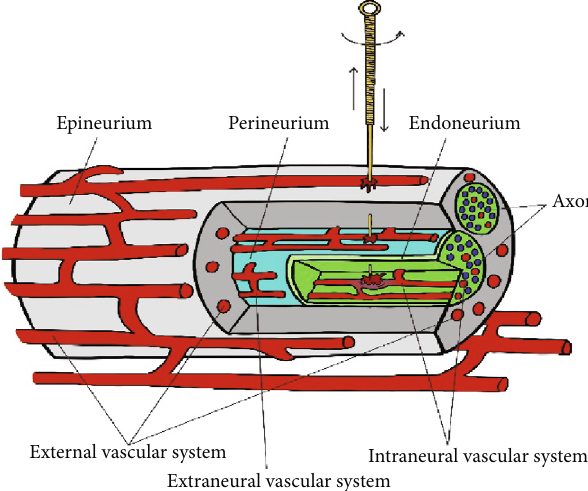
Figure 1: Microvascular injury on peripheral nerves.